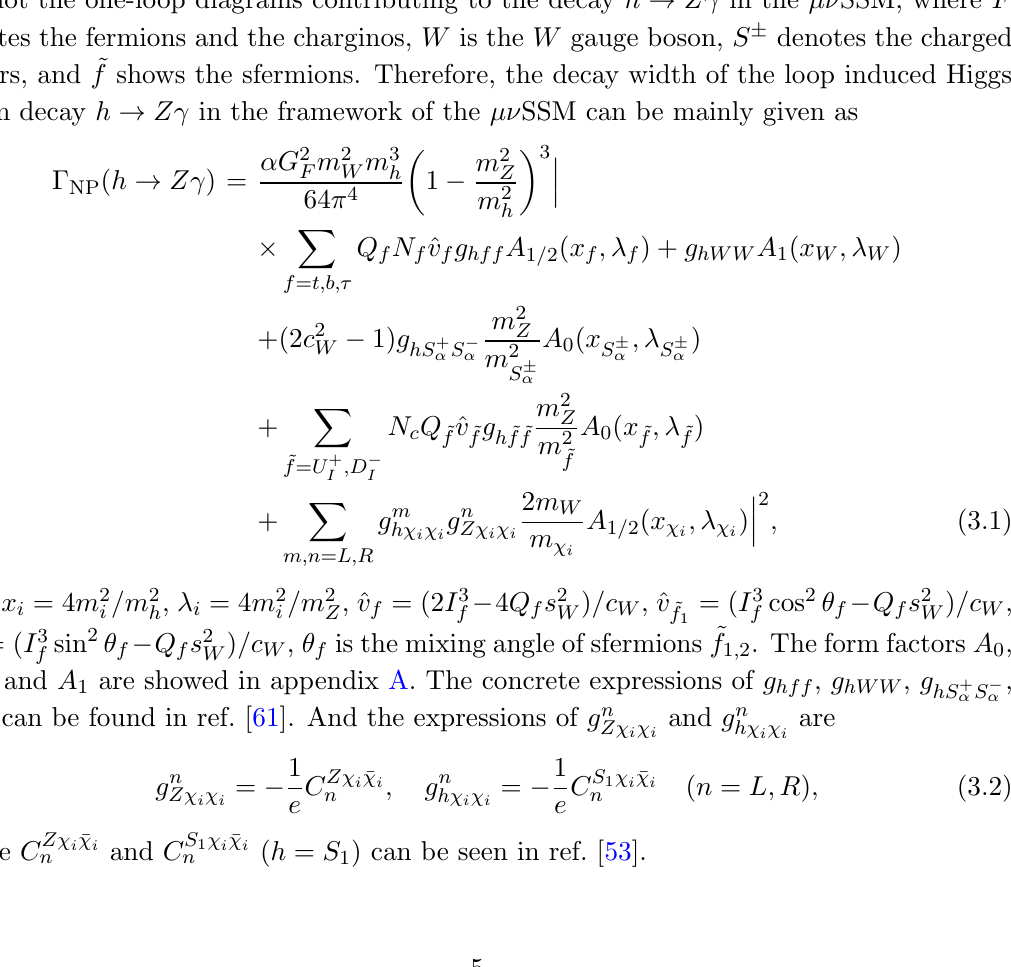
Figure 1 . The one-loop diagrams contributing to the decay h denotes the fermions and the charginos, W is the W gauge boson, S (cid:6) denotes the charged scalars, and ~ f shows the